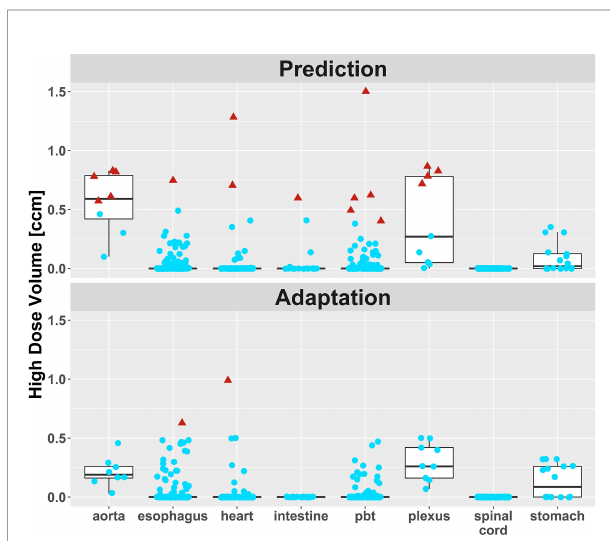
FIGURE 5 | High dose volumes of different organs-at-risk (OAR). Blue dots: High dose volume lies below the planning objective (mostly <0.5 cm³). Red triangles: High dose volume exceeds the planning objective. There was one remaining fraction with two moderate OAR constraint violations in an ultracentral lung tumor, where a compromise between target volume coverage and dose inside the OAR was chosen. No more OAR constraint violations occurred in this patient.